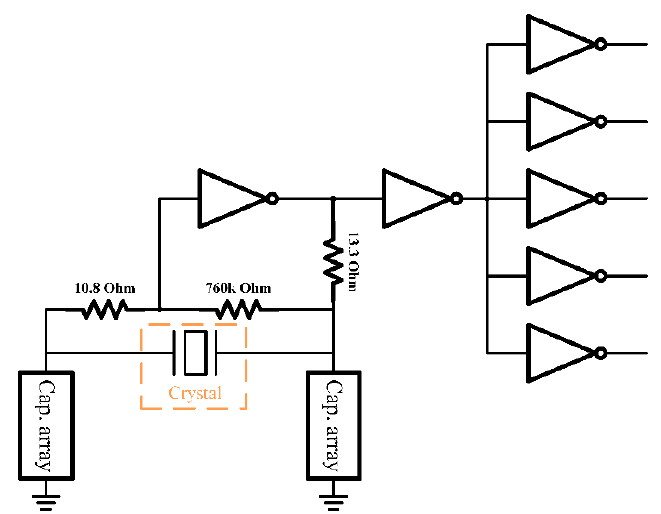
Figure 11. Chip micrograph of the proposed PLL.